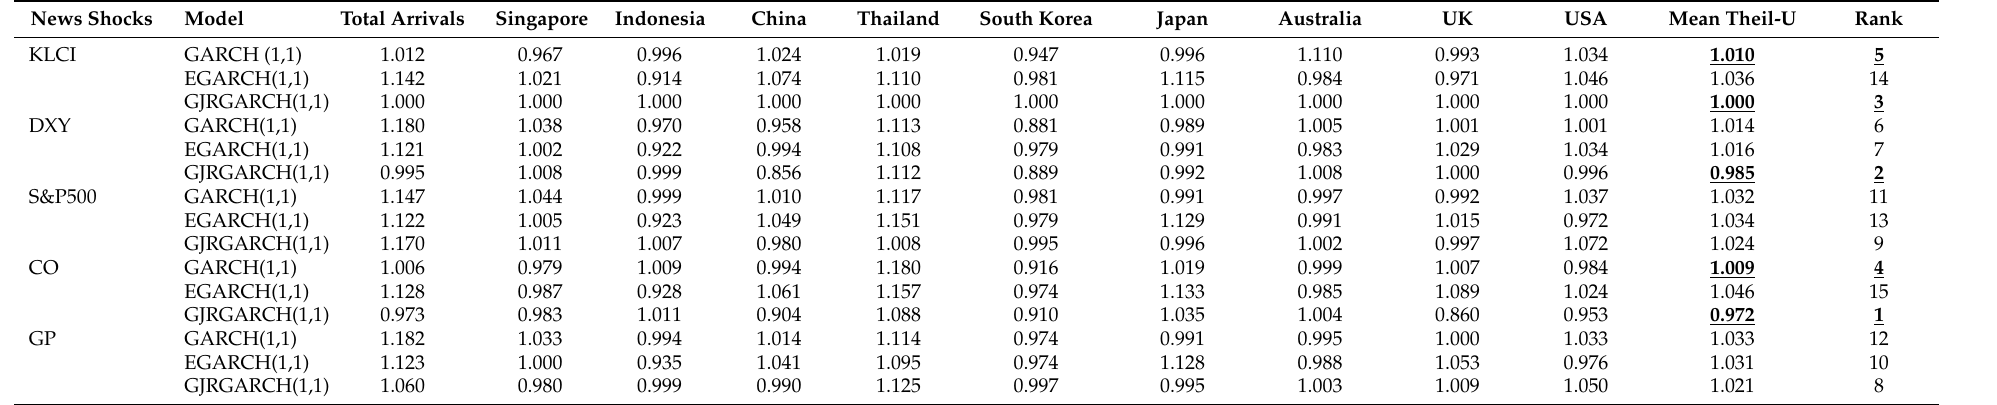
Table 11. Tourism demand volatility prediction methods based on RMSE for in-sample one-step-ahead predictions. News